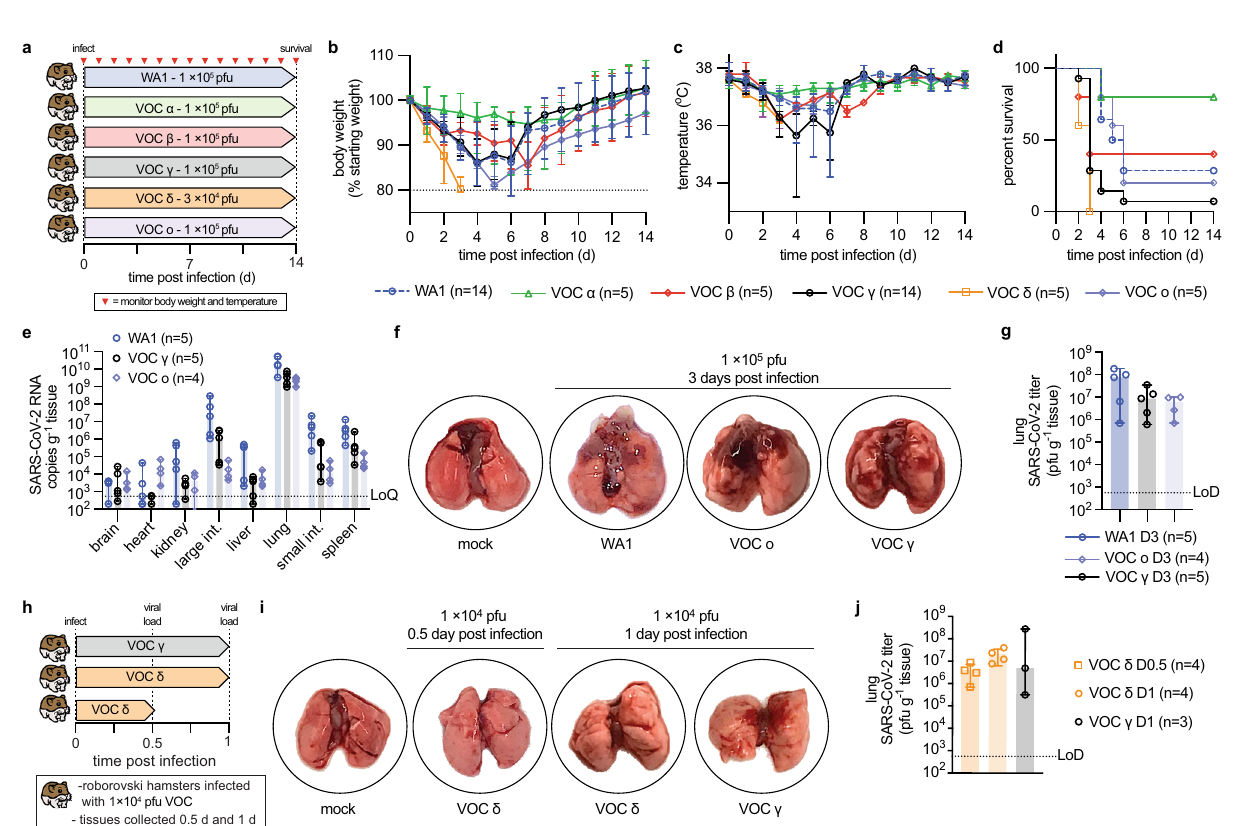
(right). Symbols in b , d – f represent independent biological repeats (virus load of individual animals), lines ( b , d – f ) intersect group medians, and columns ( c , e – g ) show group medians ±95% con fi dence intervals. Statistical analysis with one-way ( d – f turbinate titers) or two-way ( b , d – f lavage titers) ANOVA with Tukey ’ s ( d – f turbinate titers) or Sidak ’ s ( b , d – f lavage titers) posthoc multiple comparison tests; P valuesareshown,NSnotsigni fi cant,LoDlimitofdetection.Sourcedataare provided as a Source Data fi le.